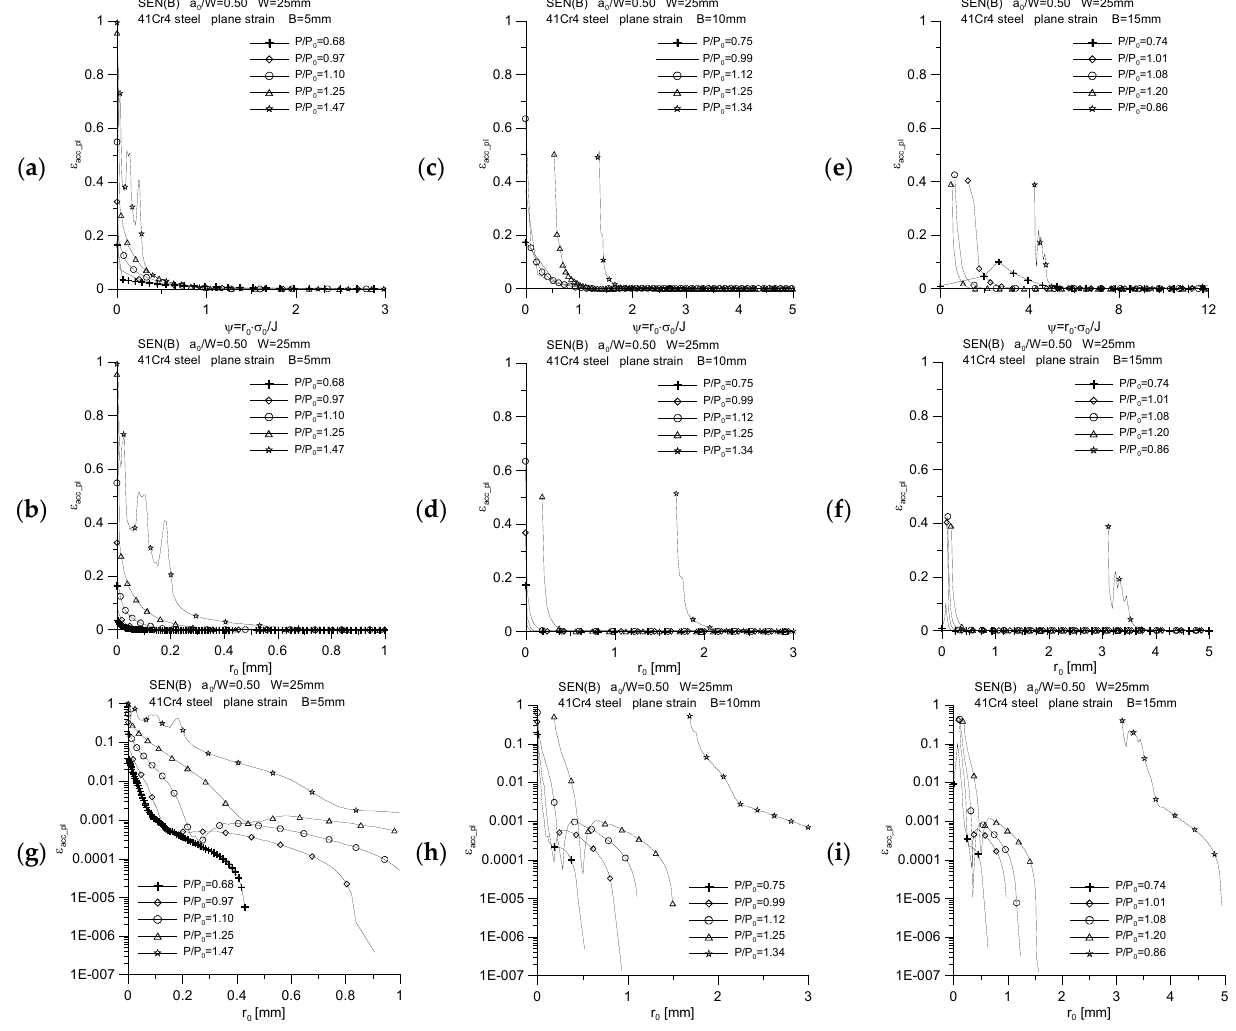
Figure 14. Distribution of accumulated plastic strains, ε acc_pl , near the crack tip, for three specimens used in the crack propagation simulation. The graphs ( a , c , e ) were made for the normalized distance from the crack tip, ψ = r 0 ∙ σ 0 / J , while the graphs ( b , d , f ) were prepared for the physical distance from the initial crack tip position, r 0 . In the graphs marked with ( g , h , i ), the ordinate scale is presented in logarithmic form to illustrate the level of accumulated plastic strains more accurately in front of the crack tip, for different levels of external load. The figures show the distributions for the characteristic moments provided in Table 2.